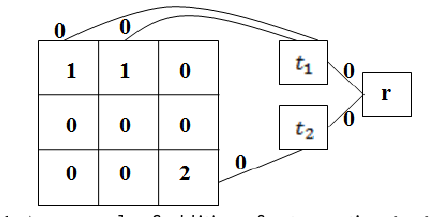
Figure 1. An example of addition of extra vertices 𝐭 𝟏 , 𝐭 𝟐 and r to the image graph for the construction of an MSF rooted on markers 1 and 2; non-marker pixels are denoted by “0.”